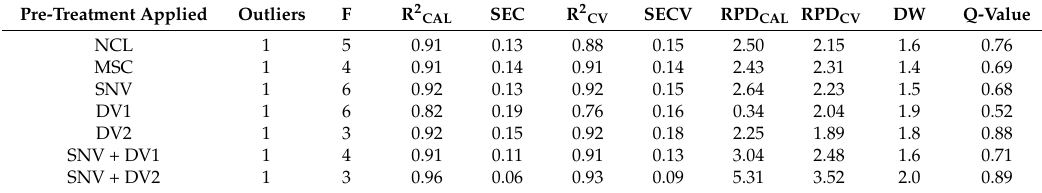
Table 1. The optimal partial least squares (PLS) model prediction results for total organic carbon (TOC) and the corresponding statistical parameters of the various single and combined pretreatments for the DS set (NCL = normalization by closure; MSC = full-multiplicative scatter correction,